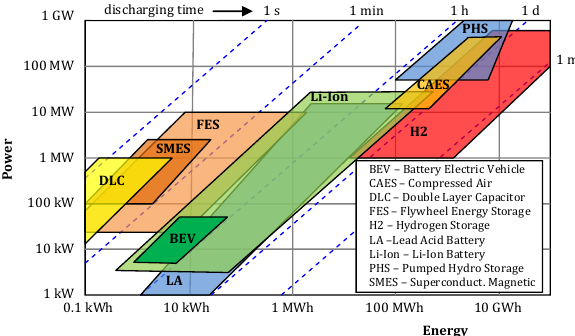
Fig. 2. Energy storage systems classification tree [2]